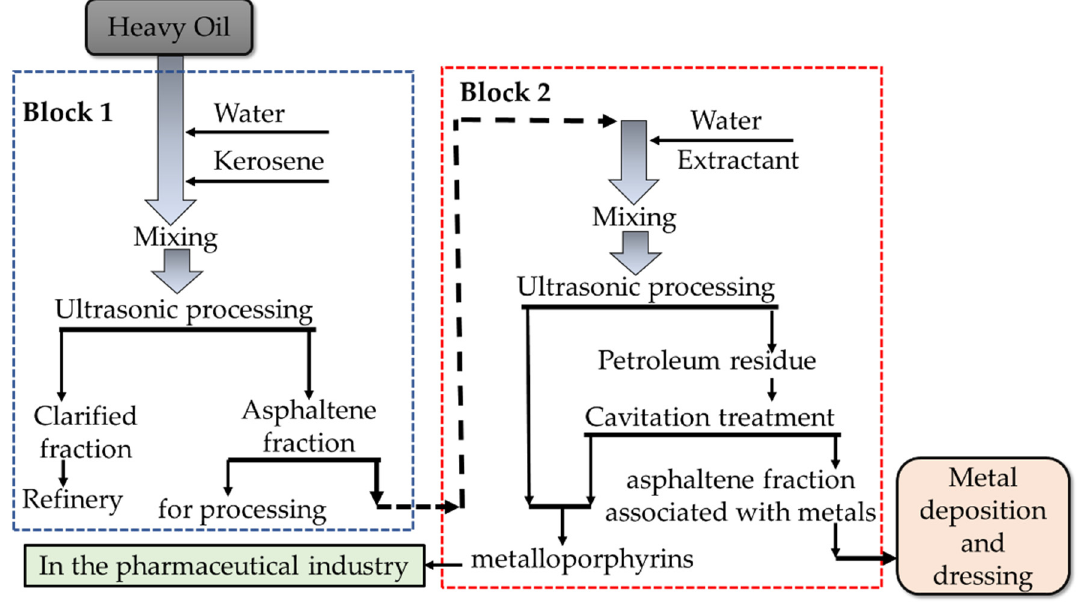
Figure 4. The cavitation extraction system for extracting heavy metals from heavy oil of the Yaregsky deposit.